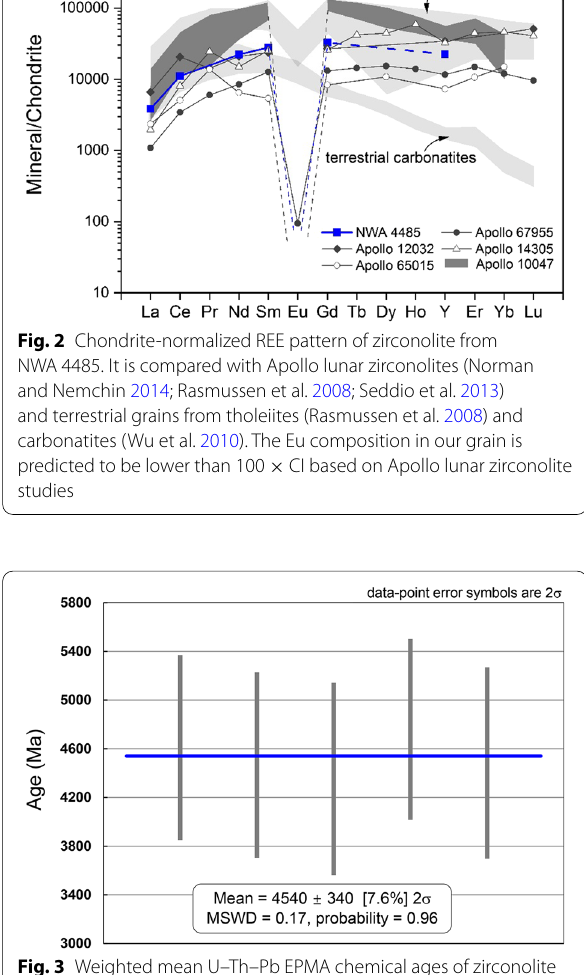
Table 2 Pb isotopic data of zirconolite in NWA 4485 obtained by NanoSIMS